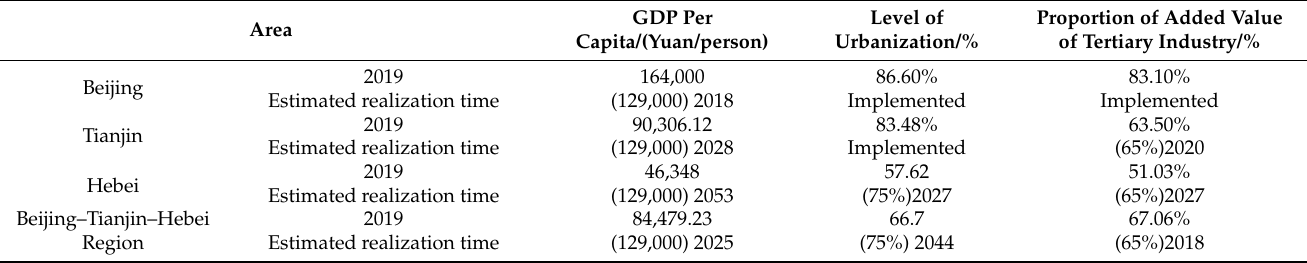
Figure 5. Indicators of carbon emission period forecast in the Beijing–Tianjin–Hebei region from 2012 to 2019. to 2019. Table 2. The prediction results of the carbon peak